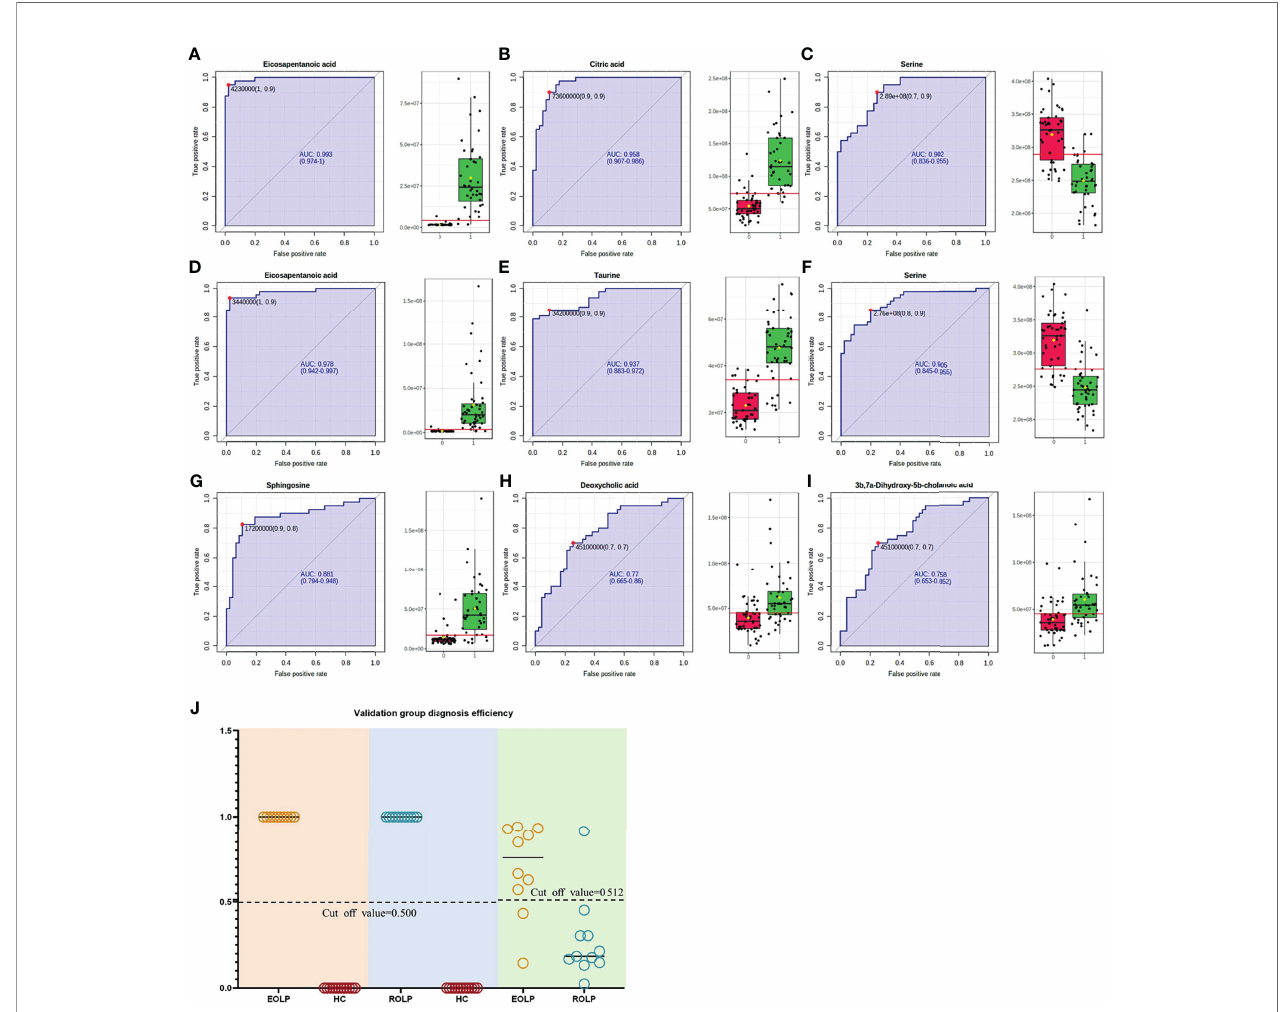
FIGURE 9 | ROC curves of Eicosapentanoic acid (A) , Citric acid (B) , and Serine (C) in the EOLP group and HC group; Eicosapentanoic acid (D) , Taurine (E) , and Serine (F) in the ROLP group and HC group; Sphingosine (G) , deoxycholic acid (H) , and 3b,7a-Dihydroxy-5b-cholanoic acid (I) in the EOLP group and ROLP group. Validation group diagnosis ef fi ciency (J)